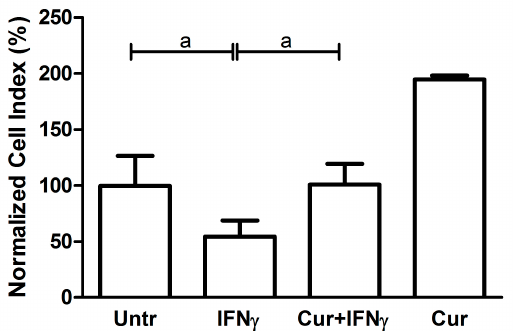
Figure 6. Impedance analysis of HT29 pre-treated with curcumin. The HT29 cells were pre-treated with curcumin (Cur, 24 h after seeding), and stimulated with IFN γ (48 h after seeding). The histograms represent, as a percentage (%), the mean of the normalized cell index values, reached after about 48 h IFN γ stimulation, compared to the untreated condition (Untr). Data are expressed as the mean ± SD. Data analyses were performed with one-way ANOVA and the Bonferroni post-test (a: p < 0.05).